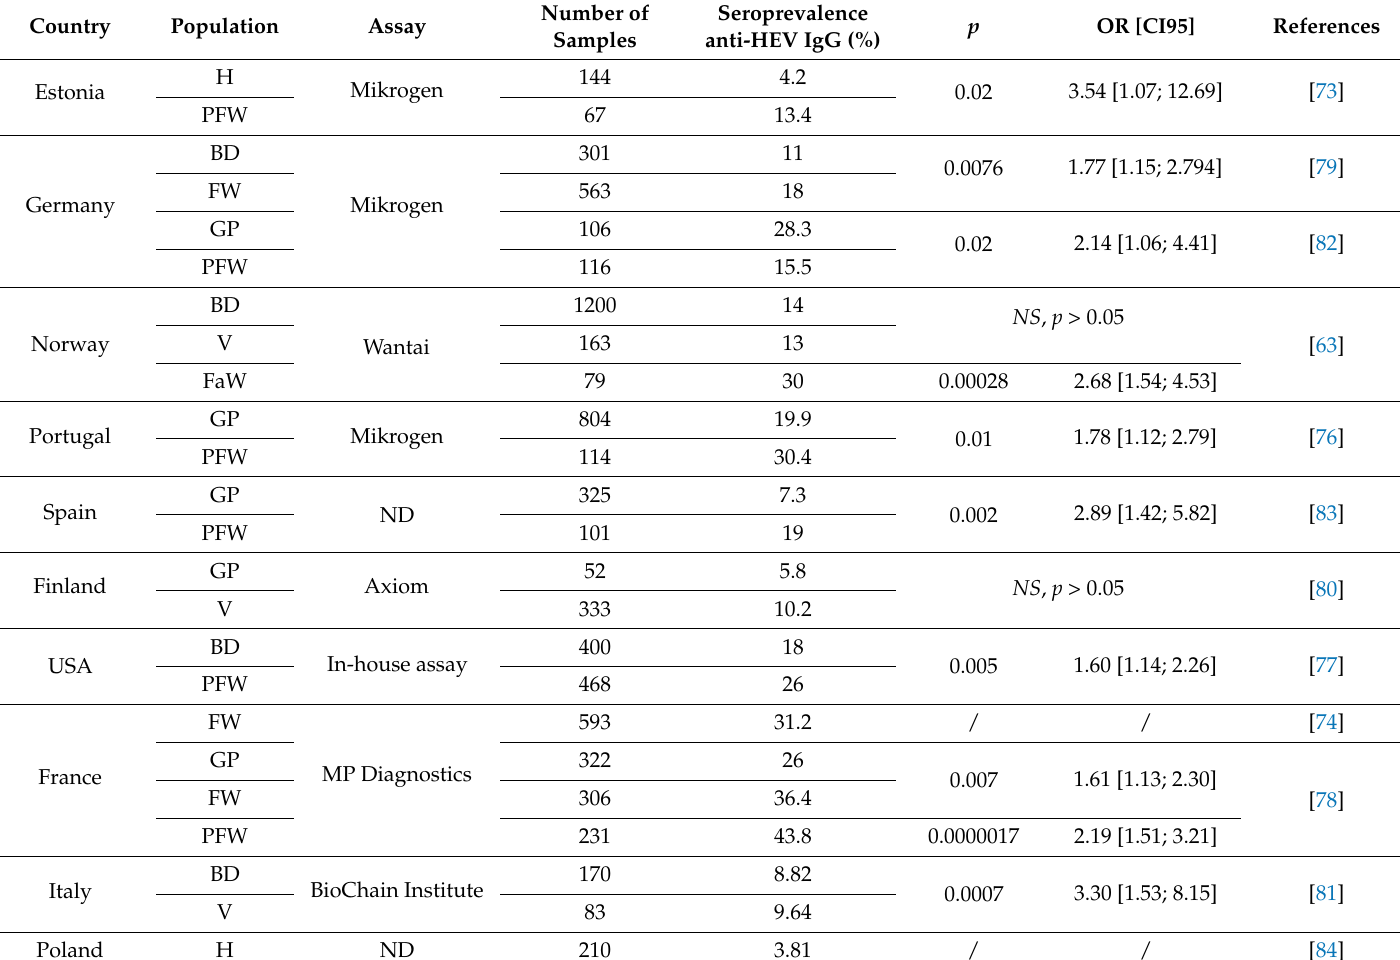
Table 3. HEV IgG rates observed in different